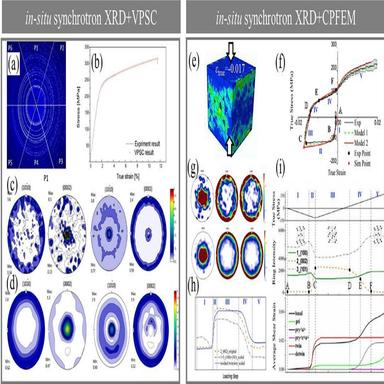
Comparison of results from SR-XRD and numerical simulation: (a) the caked in-situ diffraction images; (b) stress–strain curves; (c, d) experimental and simulated pole figures ; (e) residual twin shear strain; (f) stress-strain curve; (g) initial texture; (h) superposition of intensity plot; (i) change of quantities .